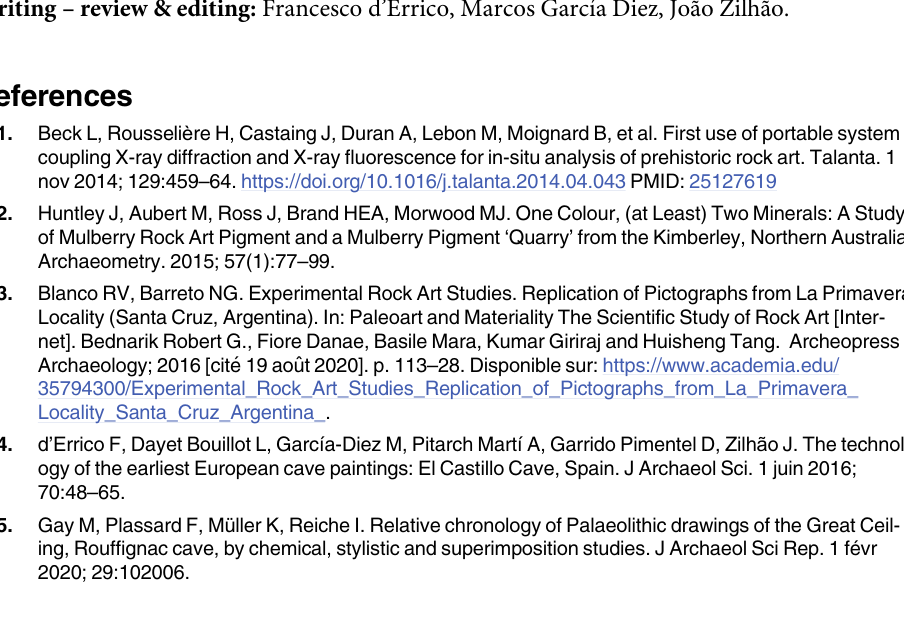
S1 Table. Counts of pXRF measurements (raw